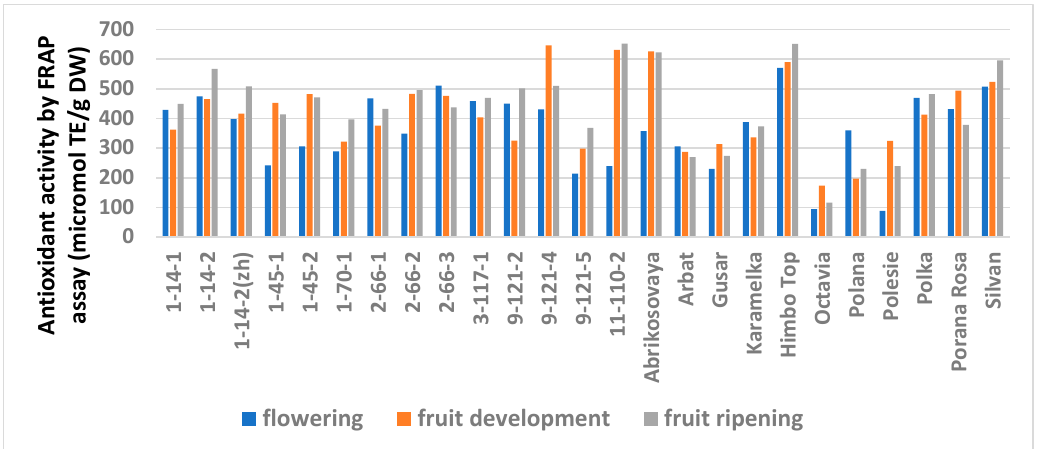
Figure 3. Effect of different harvest periods (phenophase) on antioxidant activity of raspberry leaves measured by FRAP assay. Statistical analysis of the data is presented in Table S7.